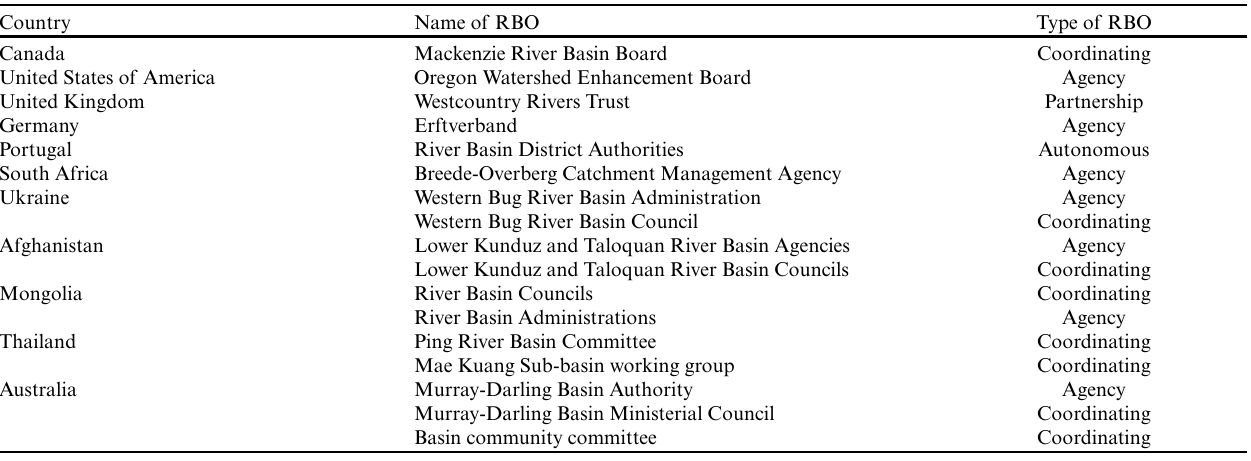
Table 1. Characterization of the river basin organizations